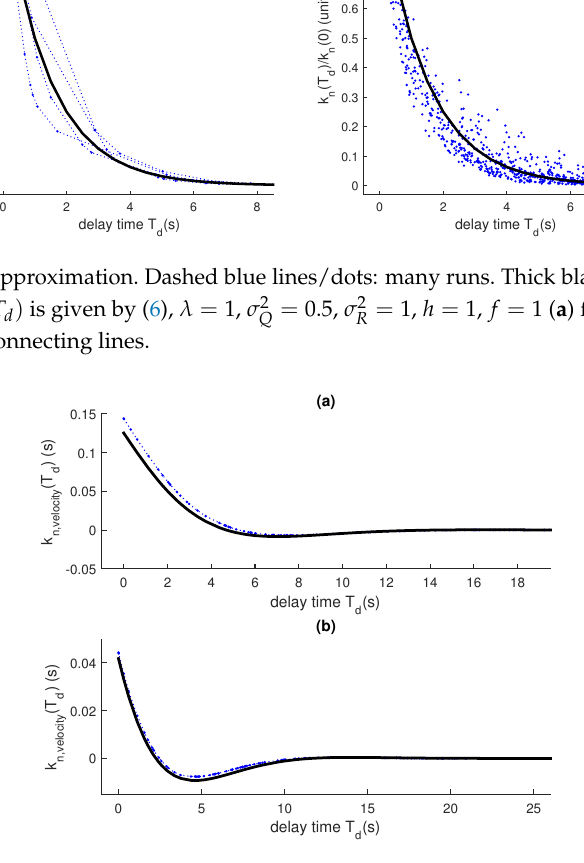
Figure 3. Approximation with a velocity component. Dashed blue lines/dots: One run. Thick black line: ( 1 − KH ) T / ∆ T K , where K is found by solving the DARE. ∆ T = 1/5, Q = 0.01 H = [1 0], F